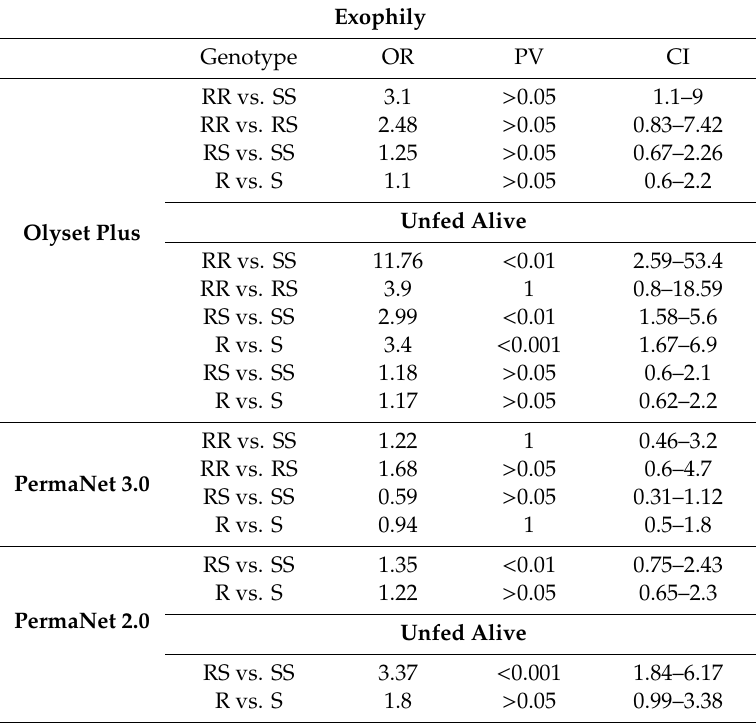
Table 6. Impact of L119F-GSTe2 mutation on the e ffi cacy of various bed nets in